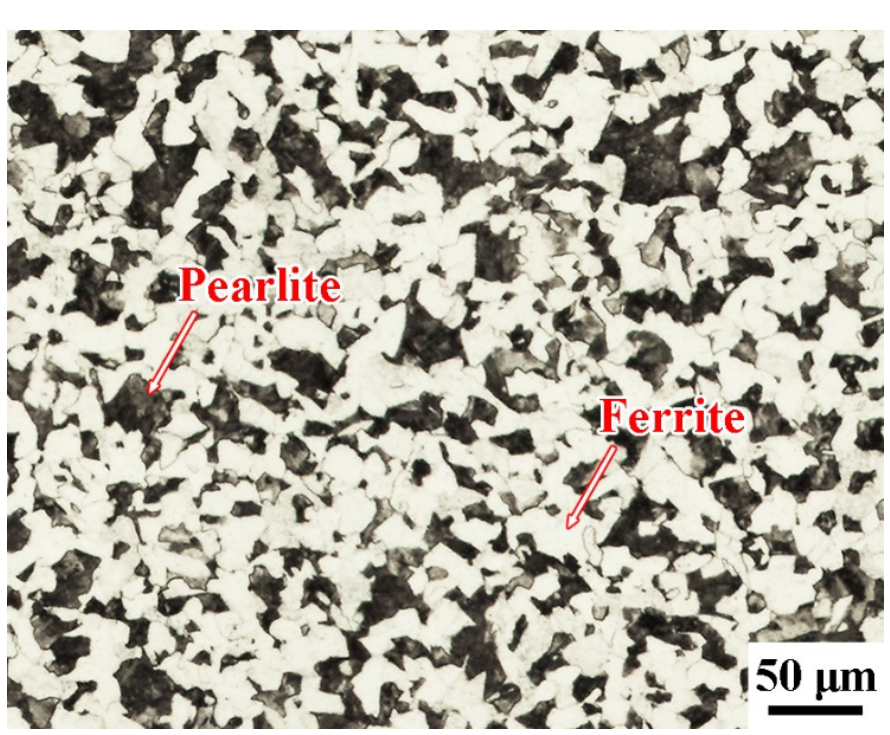
Figure 1. The microstructure of S1 at room temperature. To further avoid the influence of surface oxidation, the middle section of each sample was used as the surface for microstructure characterization. The section was polished to 0.5 µ m and etched by the saturated picric acid aqueous solution to reveal the original austenite GBs. The prior austenite grain structure (PAGS) was photographed and collected by an optical microscope (UOP, Chongqing, China), and the grain size was measured by the area equivalent diameter. Each sample was measured to at least 1500 (when the grains were fine) or 500 (when the grains were coarse) grains. Using the carbon replication method, the morphology and composition of the precipitates in some samples were detected by a transmission electron microscope (TEM, Oxford Instruments, Abingdon, UK) and